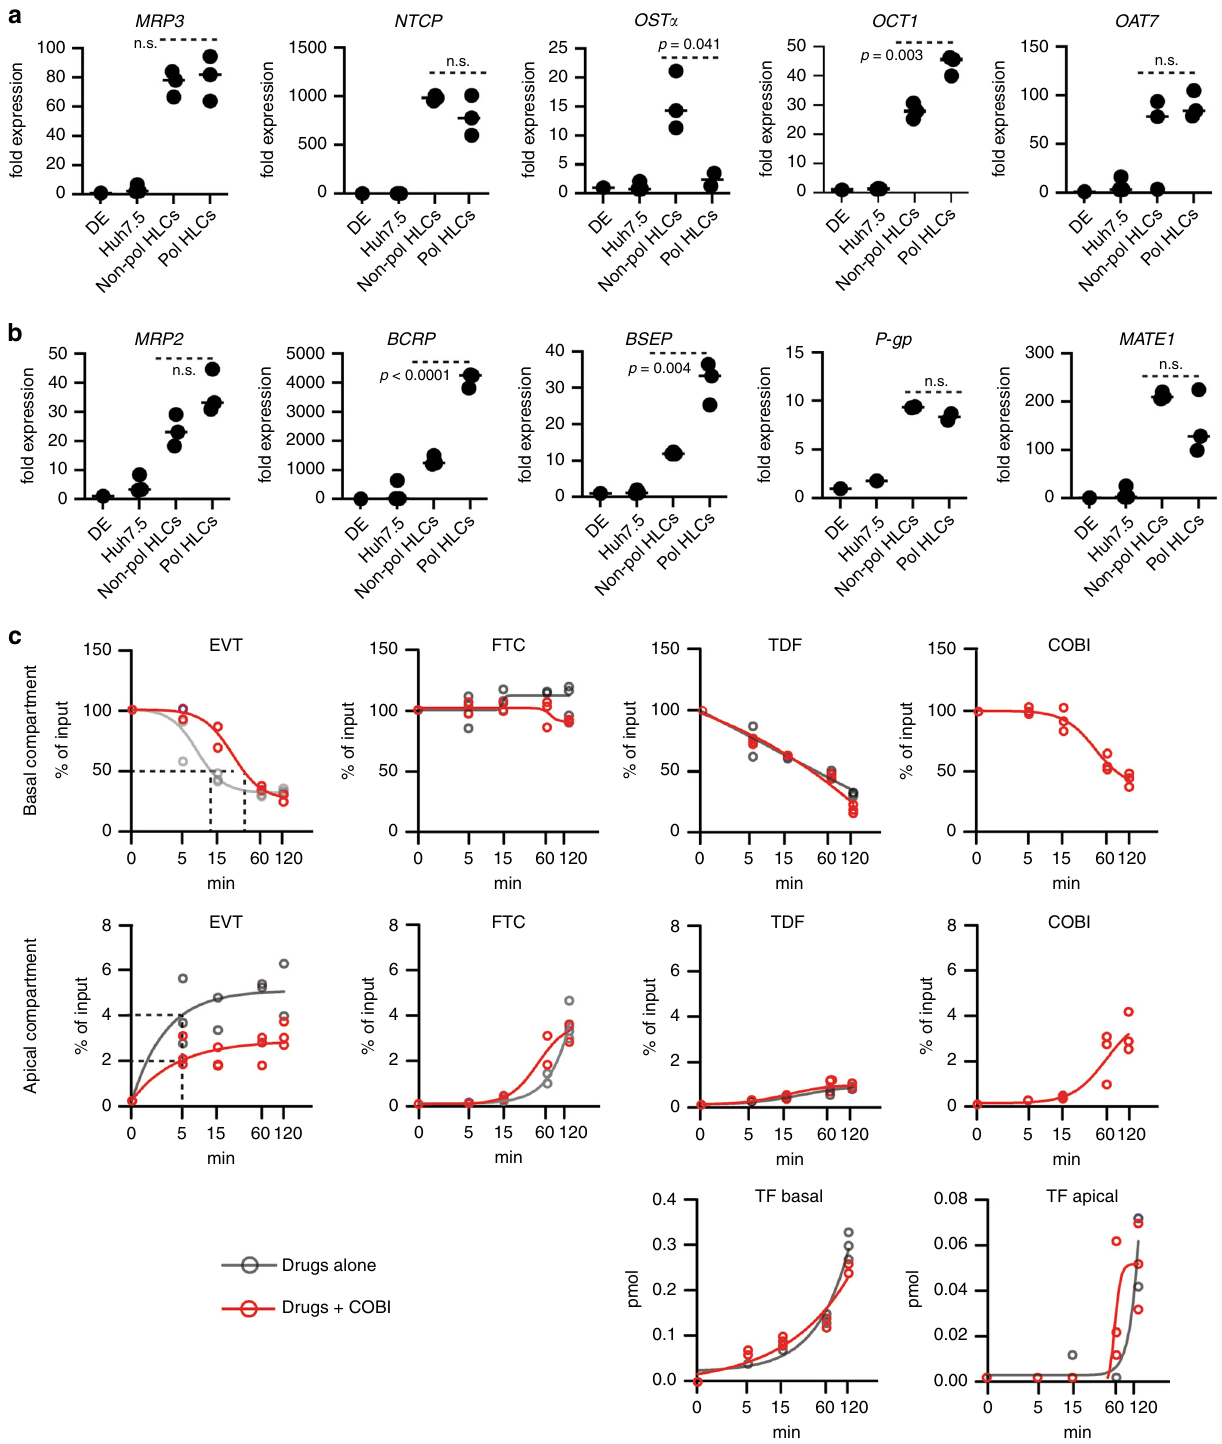
Fig. 5 Polarized HLCs for drug – drug interaction, absorption, and secretion studies. Relative mRNA levels quanti fi ed by RT-qPCR of ( a ) basolateral and ( b ) apical transporters in DE, Huh7.5, nonpol-, and pol-HLCs. Statistical analysis was performed using a two-tailed unpaired t test ( n = biological replicates). c Modeling stribild disposition in pol-HLCs. Pol-HLCs were incubated with 10 μ M elvitegravir (EVT), 13 μ M emtricitabine (FTC), 20 μ M tenofovir disoproxil fumarate (TDF) ± 10 μ M cobicistat (COBI) from the basolateral compartment. At the indicated time points, compounds and the TDF metabolite tenofovir (TF) were quanti fi ed by LC-MS in apical and basolateral compartments ( n = biological